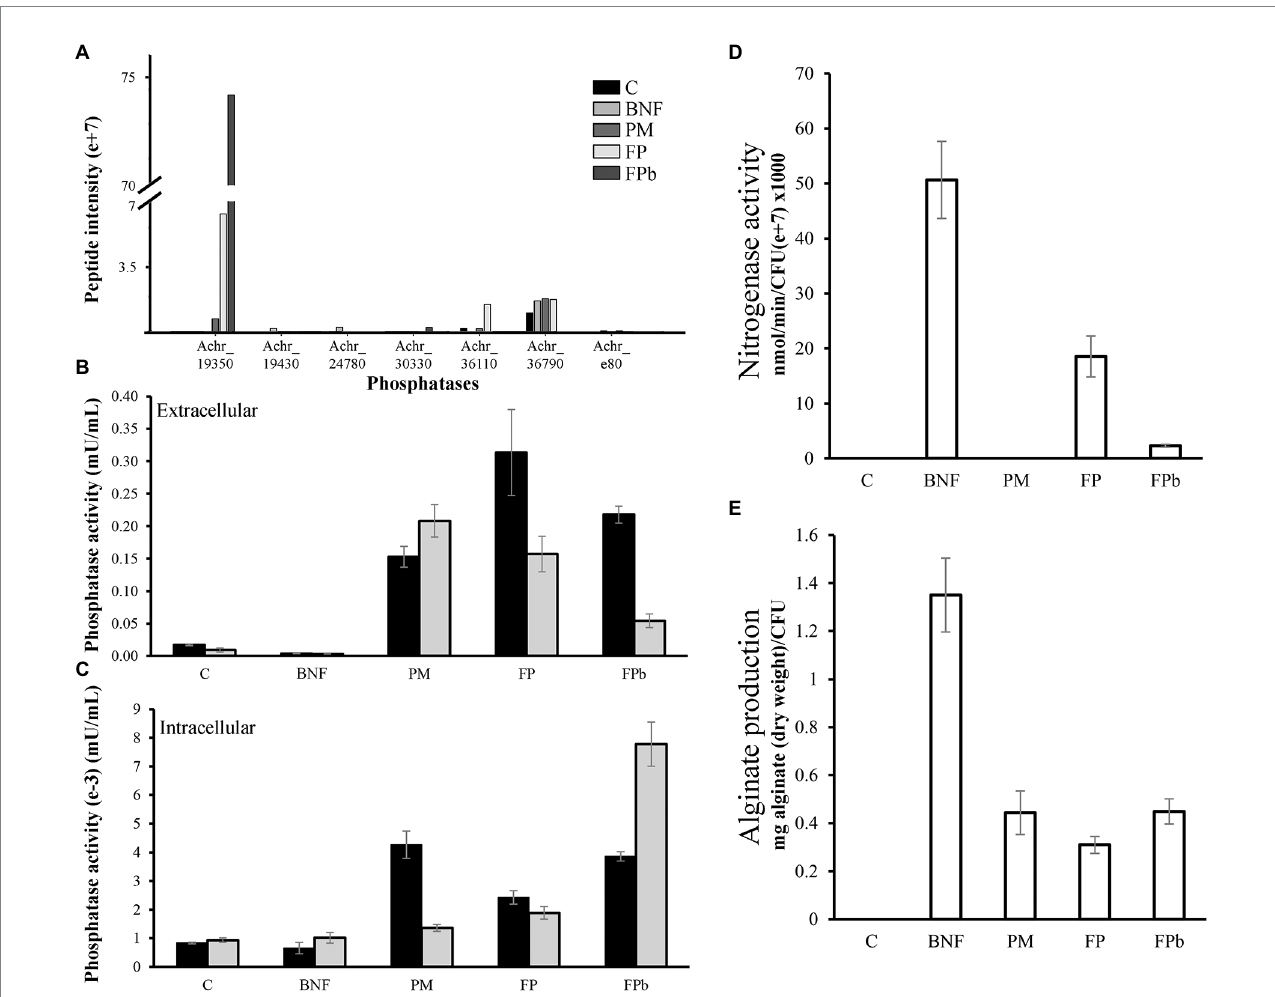
FIGURE 6 Phosphatase activities under the different experimental conditions. (A) Peptide intensities of the main phosphatases identified by proteomics. Extracellular (B) and intracellular (C) acid (black bars) and alkaline (gray bars) phosphatase activities. Achr_19430 (A0A0C4WHX1), phosphatase NudJ; Achr_30330 (A0A0C4WPA5), alkaline phosphatase; Achr_e80 (A0A0C4WXD8), Achr_36790 (A0A0C4WTQ1), exopolyphosphatase. (D) Nitrogenase activity measured by acetylene reduction assay. (E) Alginate production (mg dry weight/CFU) determined by gravimetric method. C, control condition; BNF, biological